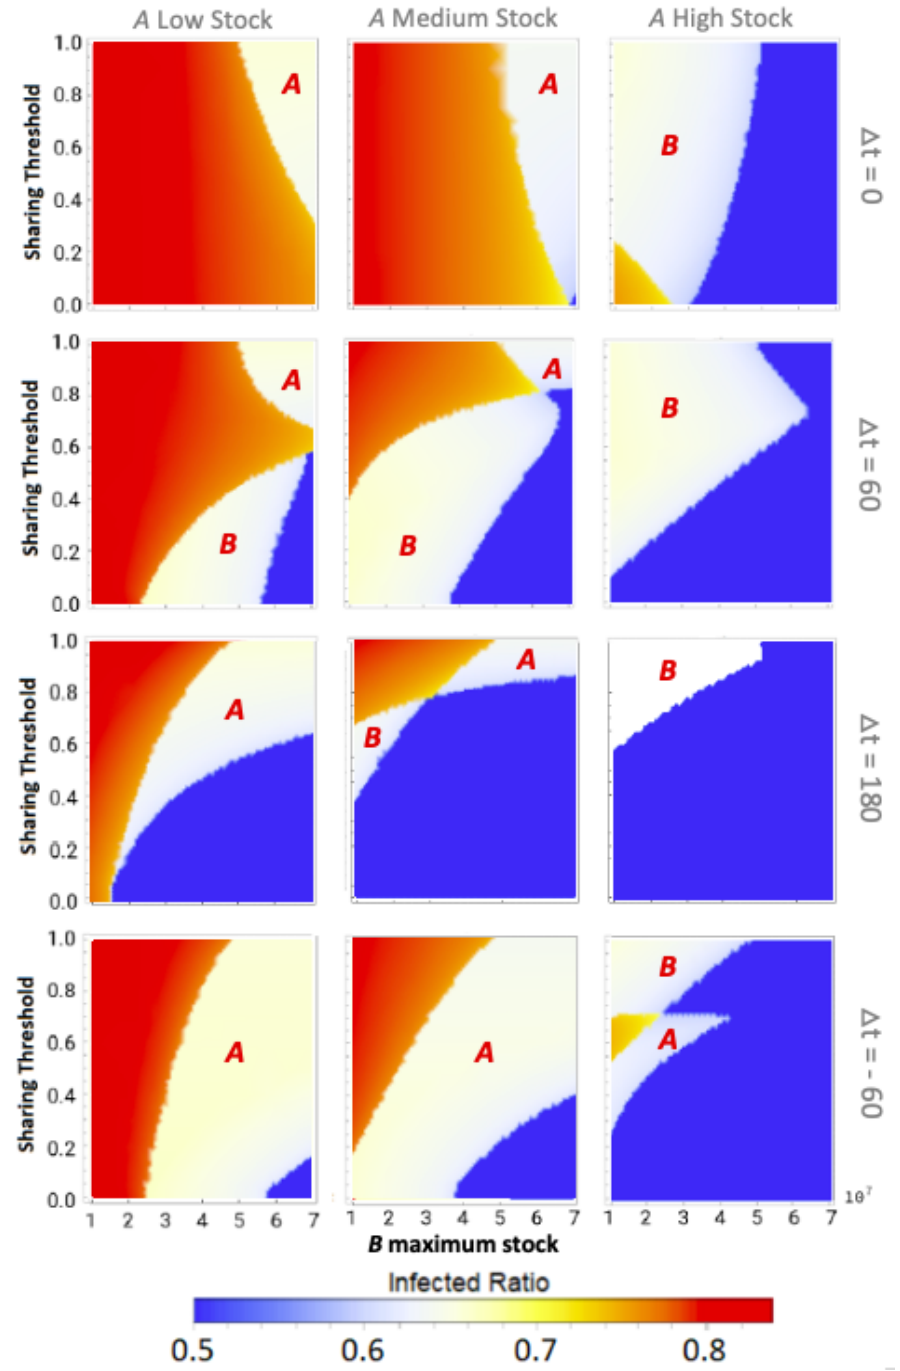
Figure A1. Influence of B maximum stock and sharing threshold on total infected ratio for differ- ent epidemic-onset time differences and fixed A maximum stock. The epidemic is introduced in A at t = 0, and in B at t = ∆ t . As a special case, the negative ∆ t = − 60 thus indicates epidemic onset in B prior to its onset in A . The maximum stock of A is fixed at either Low stock ( S max = 1 × 10 7 ), Medium stock ( S max = 3 × 10 7 ), or High stock ( S max = 7 × 10 7 ). n = 1.7 × 10 7 , R 0 = 2.3, γ = 1/6, r = 0.4, w = 4, P ( 0 ) = 5 × 10 7 , P max = 4 × P i ( 0 ) , D ( 0 ) = P ( 0 )